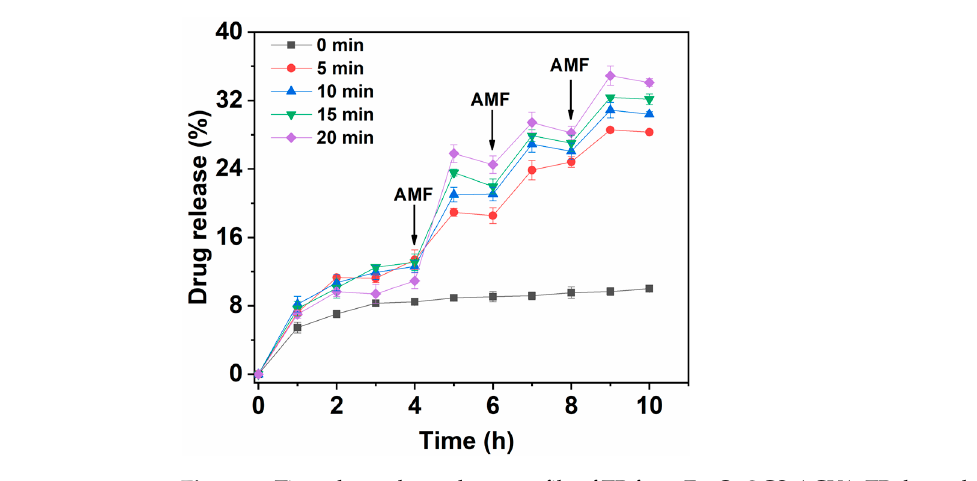
Figure 7. Time-dependent release profile of TB from Fe 3 O 4 @CS-ACVA-TB through magnetic actuation under AMF for 3 cycles. (n = 3).